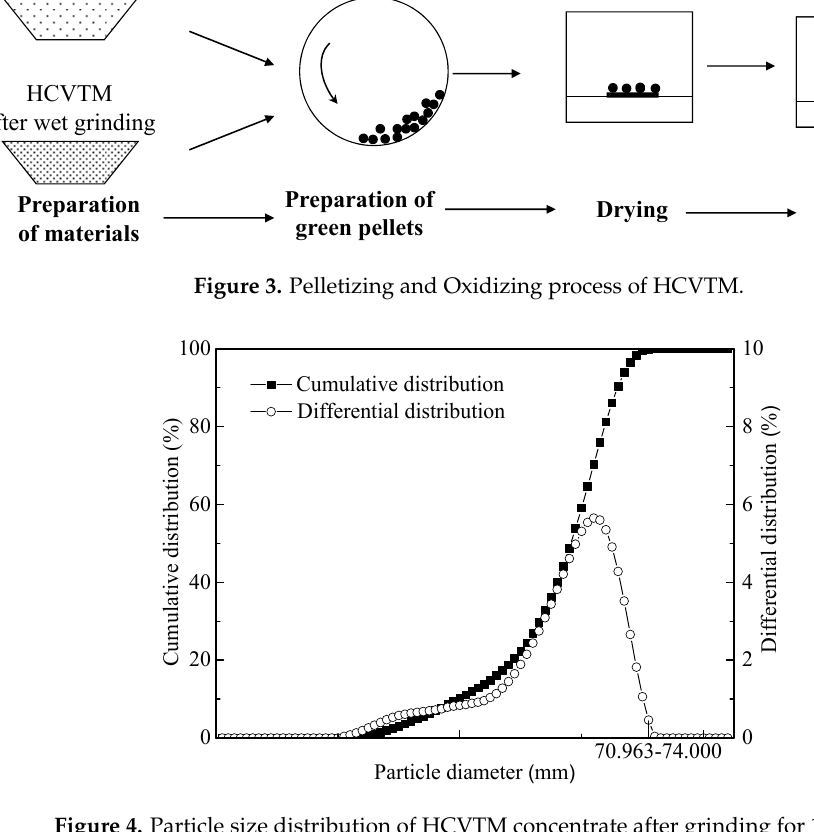
Figure 4. Particle size distribution of HCVTM concentrate after grinding for 15 min.